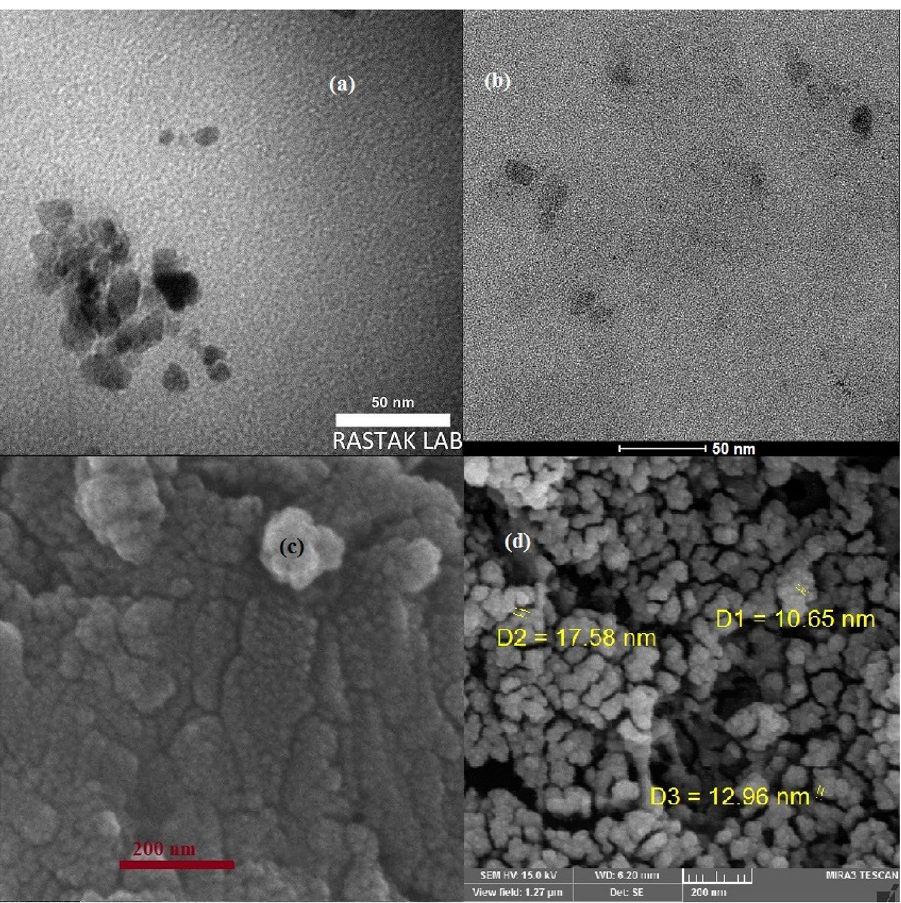
Figure 4. TEM ( a ), HR-TEM ( b ) and SEM ( c ) micrograph of N, S-GQD; SEM image of N, S-GQD/GCE ( d ).